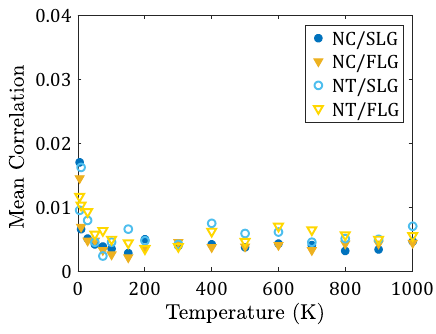
Figure 11. Mean correlation of the rotation of wheels in nanomachine/surface systems at different